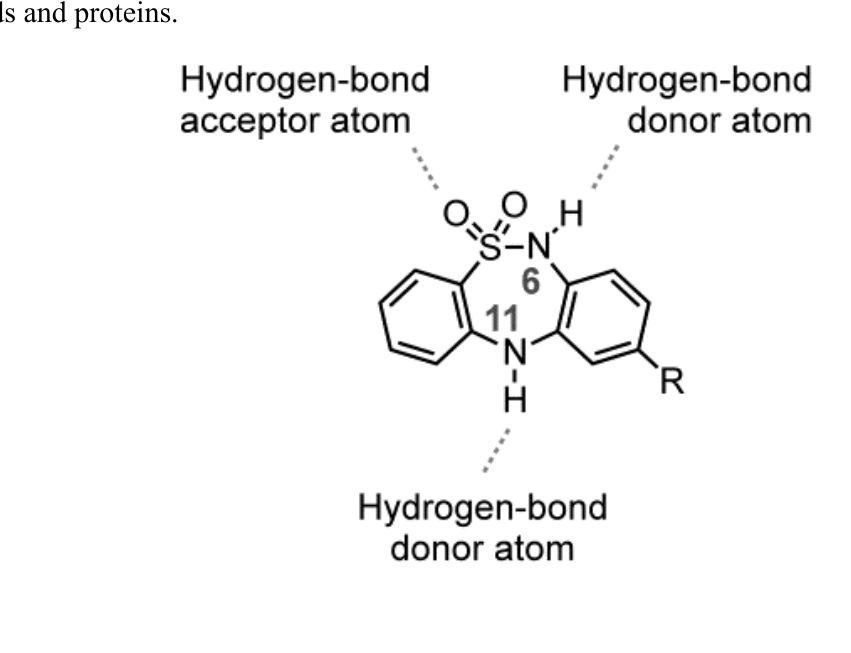
Figure 3. The dotted lines in DBTDs indicate probable interactions between hydrogen bonds and